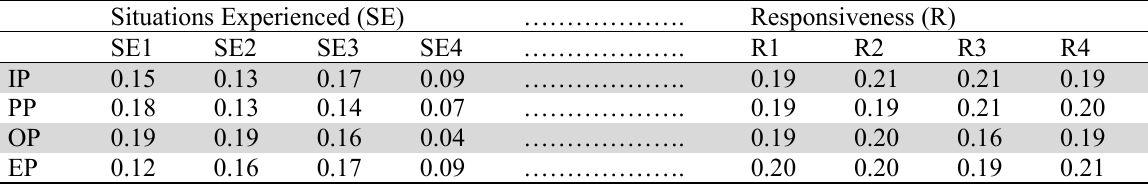
Showing normalized aggregated decision matrix Situations Experienced (SE)